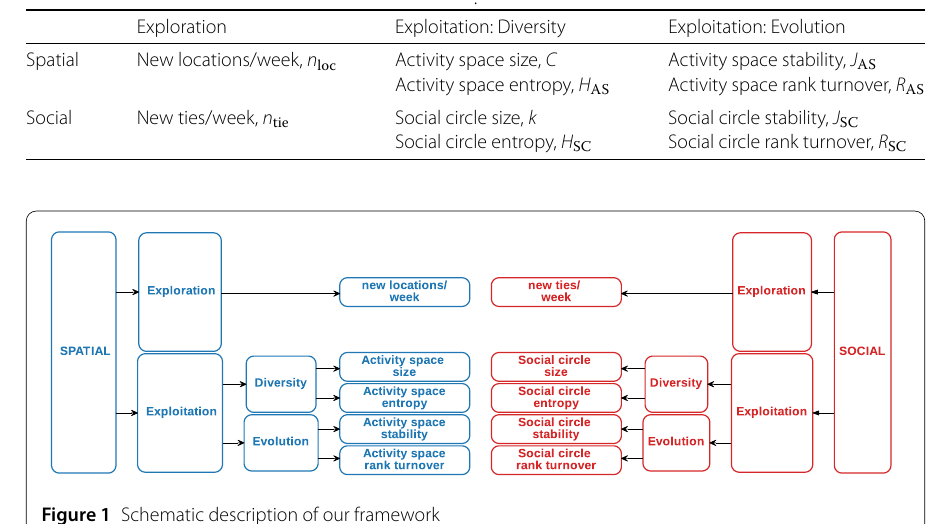
Table 4 CNS dataset: Persistence of social and spatial behaviour. For each of the social and spatial metrics, d self is the average self-distance and d ref is the reference distance between an individual and all others, averaged across individuals. The third column reports the fraction of cases where d self ( i ) < d ref ( i , j ), averaged across the population d self d ref d self ( i ) < d ref ( i , j ) Social circle size, k 0.04 ±